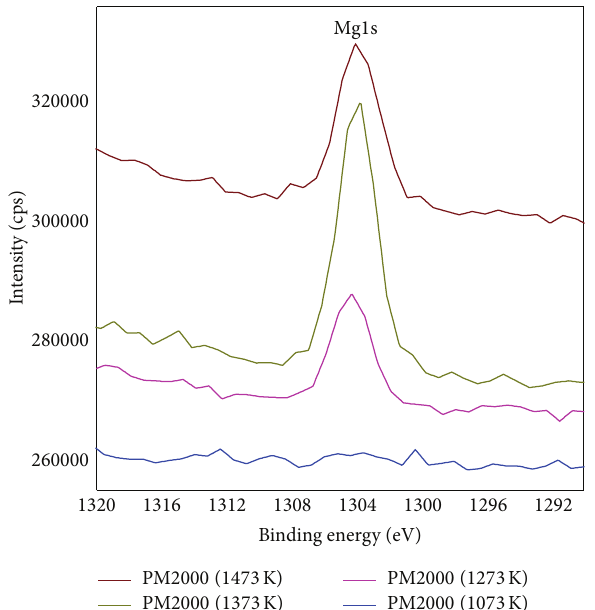
Figure 14: XPS spectra in the Mg2p region for treated PM2000 from 1073 K to 1473 K.